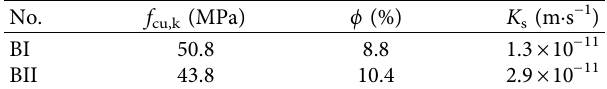
Figure 2: Cracked block preparation: (a) cube mould; (b) stainless steel mould. Table 2: Strength, porosity, and saturated hydraulic conductivity of the blocks.